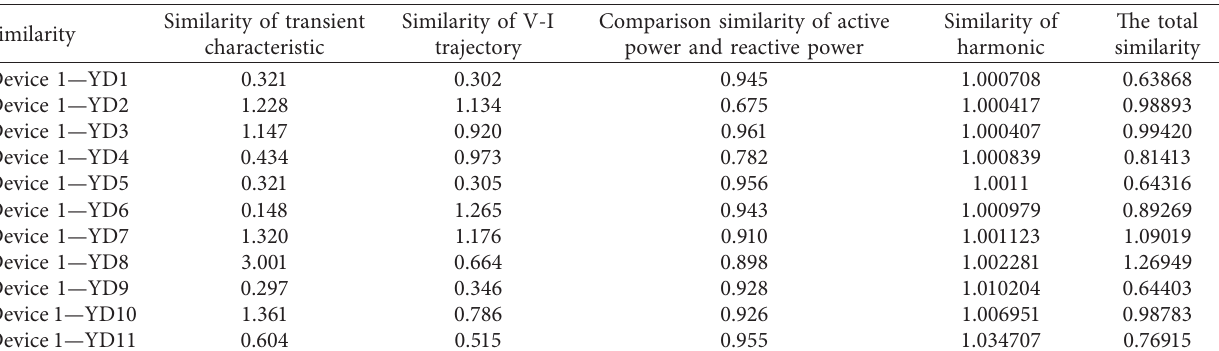
Table 9: Similarity results of device 1.